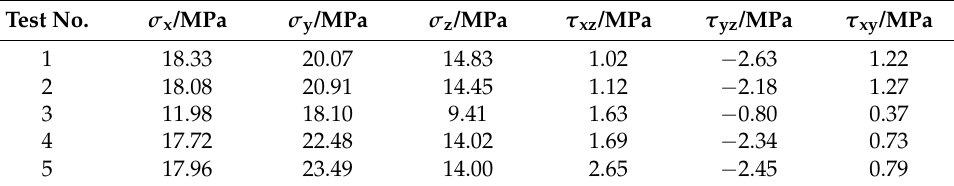
Table 5. Computational stress components at test points.